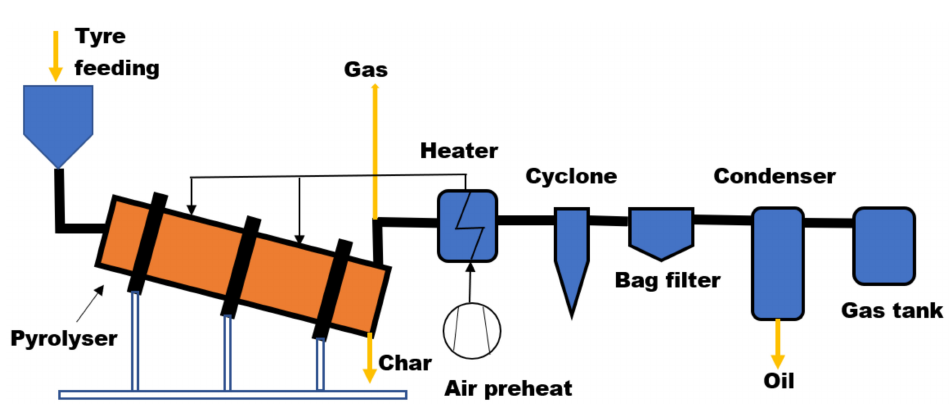
Figure 6. Diagram of a rotary kiln reactor pyrolysis reactor.